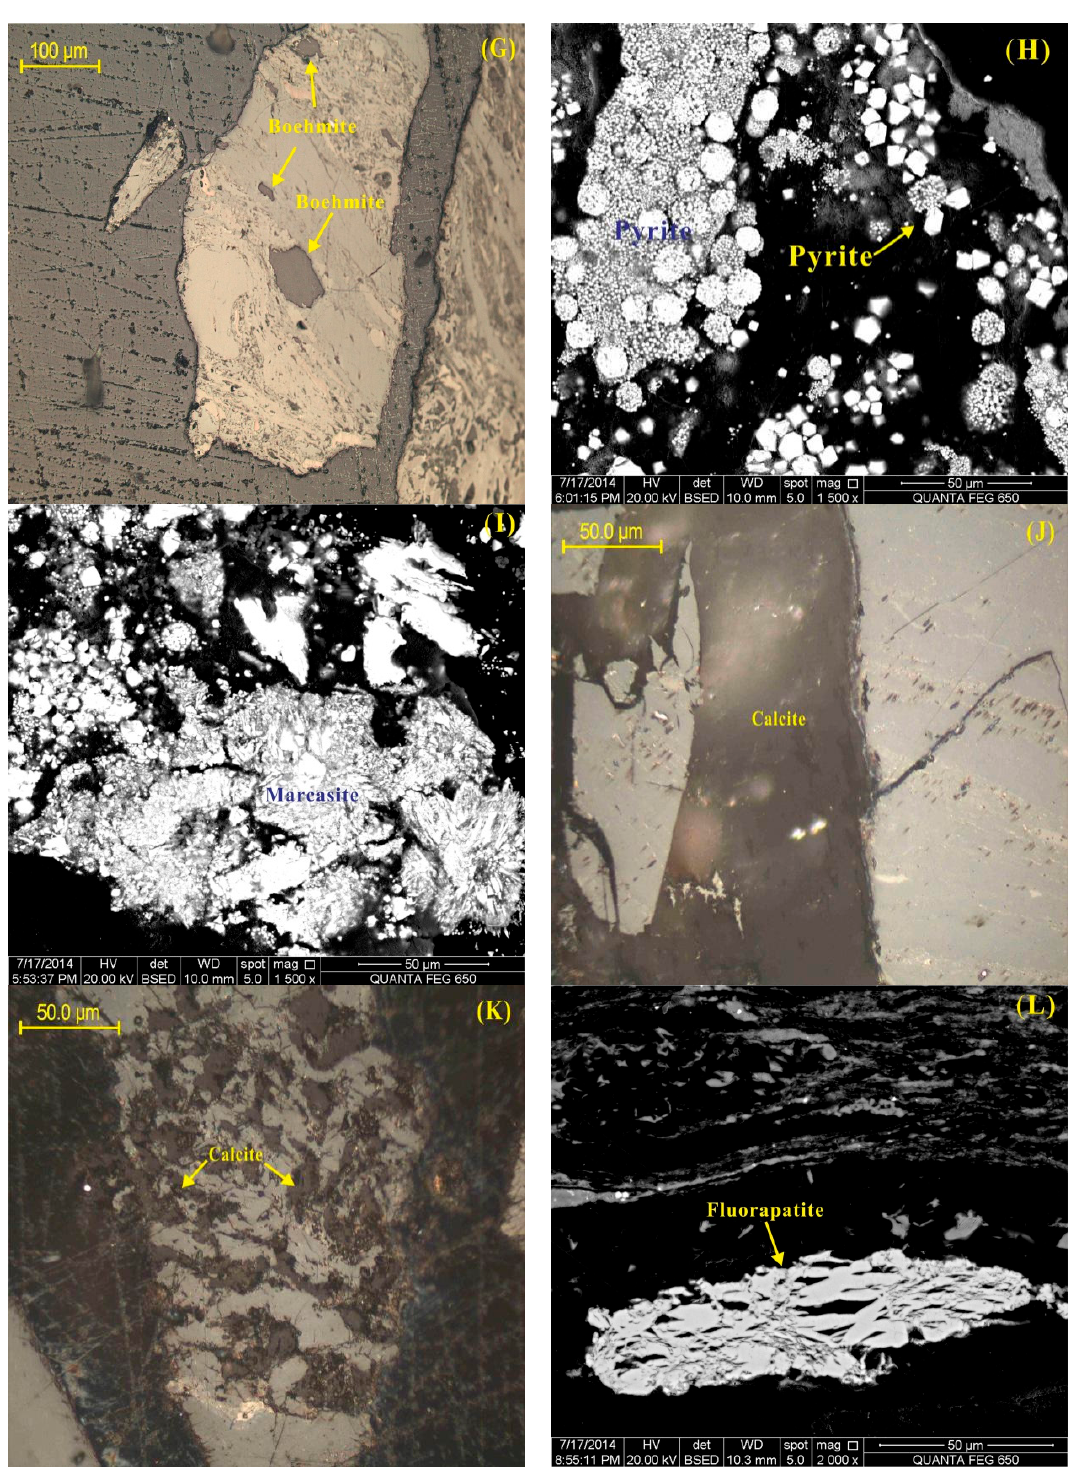
Figure 5. Minerals in the Songshao coal. ( A ) clay minerals in SS-9C; ( B ) kaolinite, illite, boehmite and florencite in SS-7C; ( C ) cell-filling kaolinite and boehmite in SS-7C; ( D ) cell-filling boehmite, illite, and anatase in SS-7C; ( E ) cell-filling boehmite, ditrital zircon, anatase, pyrite and stannite in SS-7C; ( F ) boehmite occurs small lumps and bead-like block embedded in the clay minerals and ditrital anatase in SS-7C; ( G ) boehmite in SS-9C; ( H ) framboidial pyrite in SS-1C; ( I ) plate, block and radial form marcasite in SS-1C; ( J ) vein-filling calcite in SS-3P; ( K ) cell-filling calcite in SS-3P; ( L ) fracture-filling florencite in SS-7C. B-F, H, I, L, SEM and back-scattered electron images; ( A ), ( G ), ( J ), ( K ), reflected light.